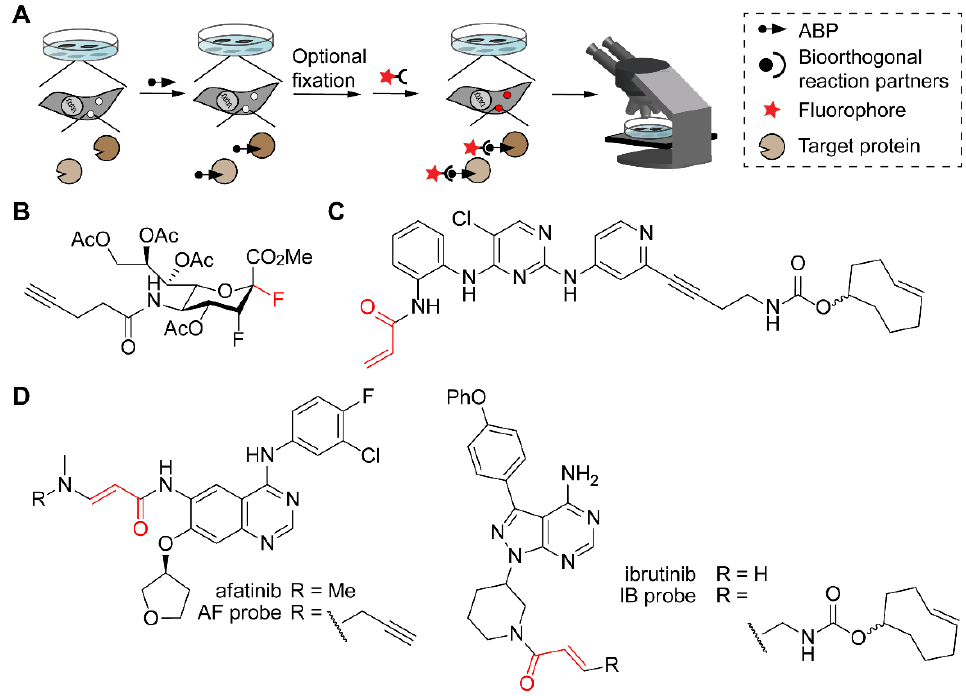
Figure 9. ABPP with fluorescence microscopy as read-out, which provides information on the (subcellular) location of the ABP targets. ( A ) Schematic representation of the workflow. Cells in culture are treated with an ABP. Depending on the bioorthogonal reaction, fixation may be necessary (e.g., in case of toxic conditions or non-cell permeable reagents). Bioorthogonal reaction then allows the introduction of a fluorophore, after which cells are imaged by a fluorescence microscope. ( B ) Structure of a fluorosialyl fluoride probe (reactive site in red). Note that the ester groups will be hydrolyzed by intracellular esterases to convert this molecule into the active probe. ( C ) Structure of the ERK1 / 2 targeting probe designed by Heightman et al. (reactive group in red) with a TCO as the bioorthogonal handle. ( D ) EGFR-targeting probe based on the drug afatinib (left) and BTK-targeting probe based on ibrutinib (right).